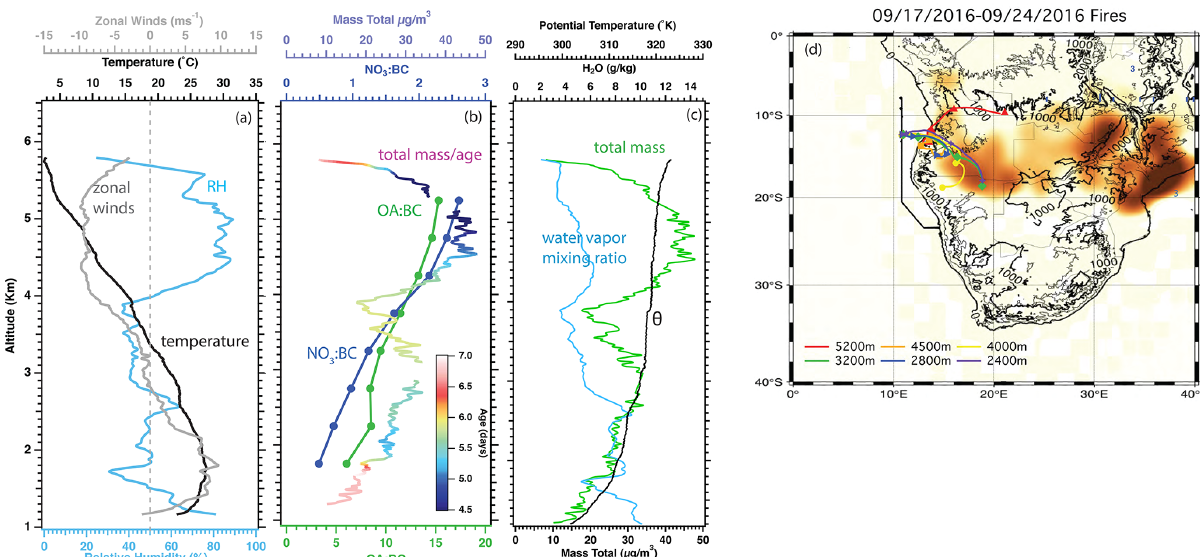
Figure 12. The 24 September 2016 (12.34 ◦ S, 11 ◦ E) vertical profiles of (a) relative humidity (%; blue), zonal winds (ms − 1 ; grey), and temperature ( ◦ C), as well as (b) the organic-aerosol-to-black-carbon mass ratio (OA : BC; green), total nitrate-to-black-carbon ratio (NO 3 : BC; blue) averaged every 500m (approximately 2min of data), and (c) total mass concentration (OA + BC + SO 4 + NO 3 + NH 4 in µgm − 3 ; 1Hz resolution) colored by aerosol age. (d) HYSPLIT trajectories, initialized on 12:00UTC of 24 September 2016 with markers placed at 00:00UTC of preceding days, superimposed on a map of fires detected between 17 and 24 September